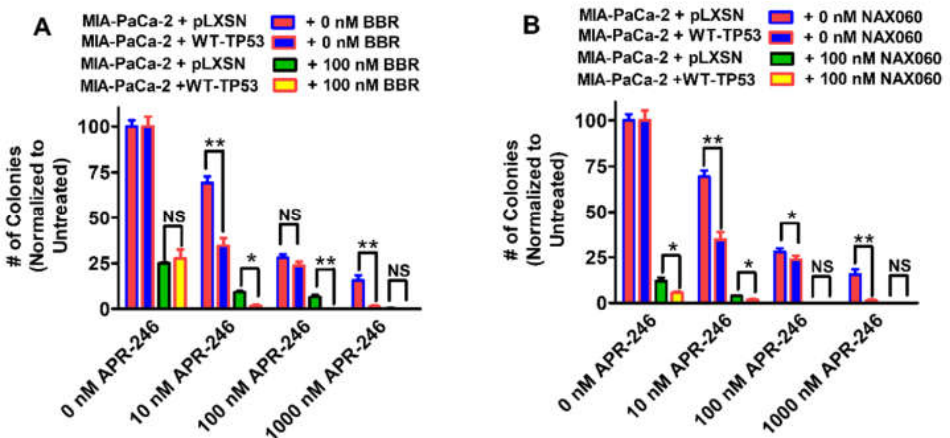
Figure 9. Both berberine and NAX60 can increase the effects of APR-246 on clonogenicity of MIA- PaCa-2 cells in the presence and absence of WT-TP53. The effects of ABR-246 on colony formation in the presence of low doses of BBR (Panel ( A )) or NAX060 (Panel ( B )) were examined. MIA-PaCa-2 + pLXSN in the absence of BBR or NAX060 (red bars), MIA-PaCa-2 + WT-TP53 in the absence of BBR or NAX060 (blue bars), MIA-PaCa-2 + pLXSN in the presence of APR-246 and 100 nM BBR (green bars), MIA-PaCa-2 + WT-TP53 in the presence of APR-246 of 100 nM NAX060 (Panel ( B )) (yellow bars). The clonogenicities for each cell type and each treatment condition were repeated 3 times, and similar results were observed. ** = p < 0.005, * = p < 0.05, NS, not statistically significant.